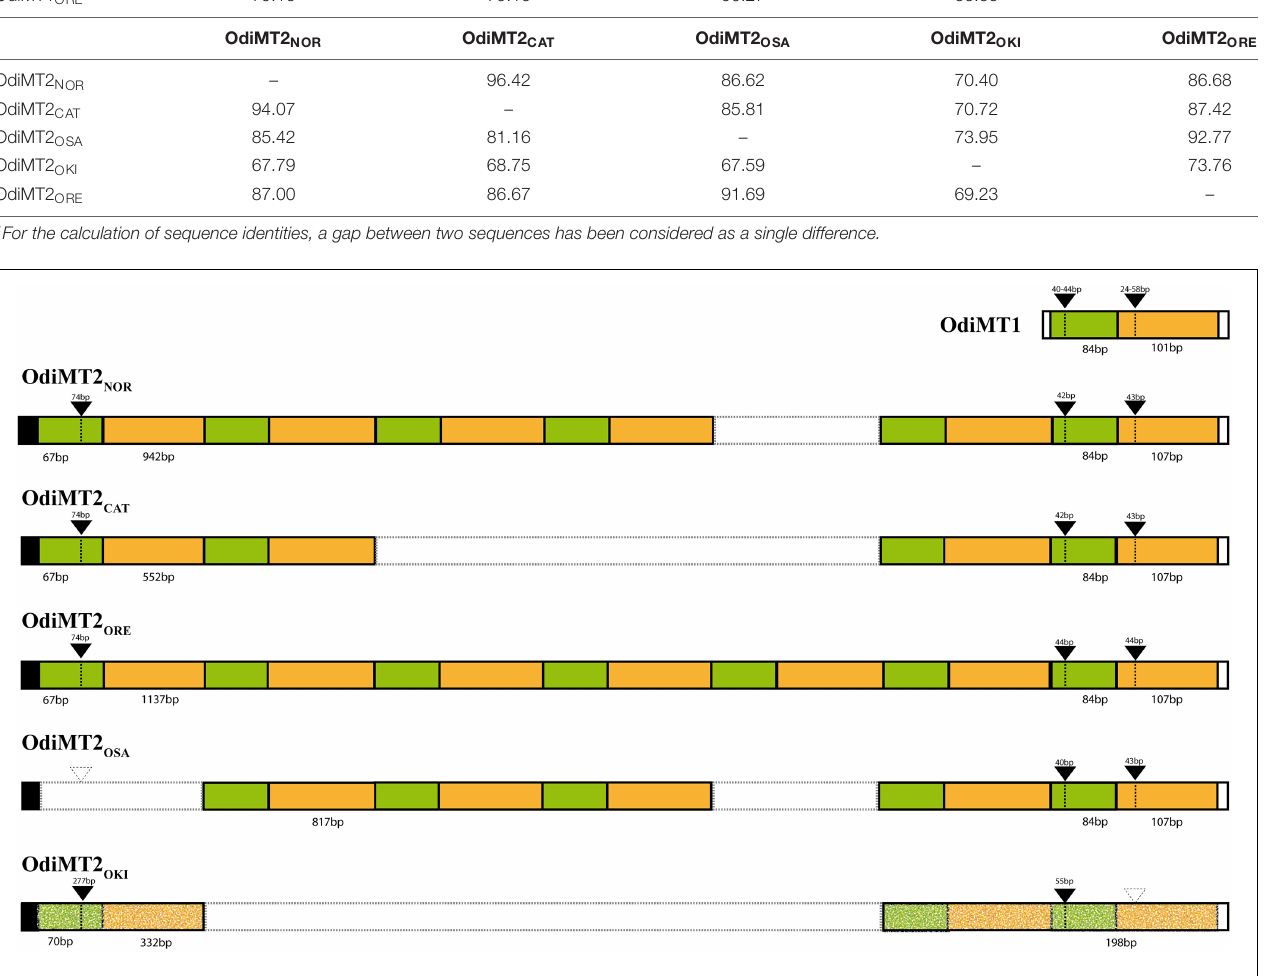
FIGURE 5 | Schematic representation of the organization of RU in OdiMTs. The t-12C/12C RU in OdiMT1s (top) and in OdiMT2 variants with six (OdiMT2 NOR ), four (OdiMT2 CAT ), seven (OdiMT2 ORE ), five (OdiMT2 OSA ), and three (OdiMT2 OKI ) RU are depicted following the color code of Figure 1 . Repeats are positioned on the basis of intron positions (black arrowheads; dashed arrowheads denote absent introns) and phylogenetic analysis ( Supplementary Figure 2 ). Exon and intron sizes are indicated. The high divergence of the RU of OdiMT2 OKI is highlighted by the dotted pattern.